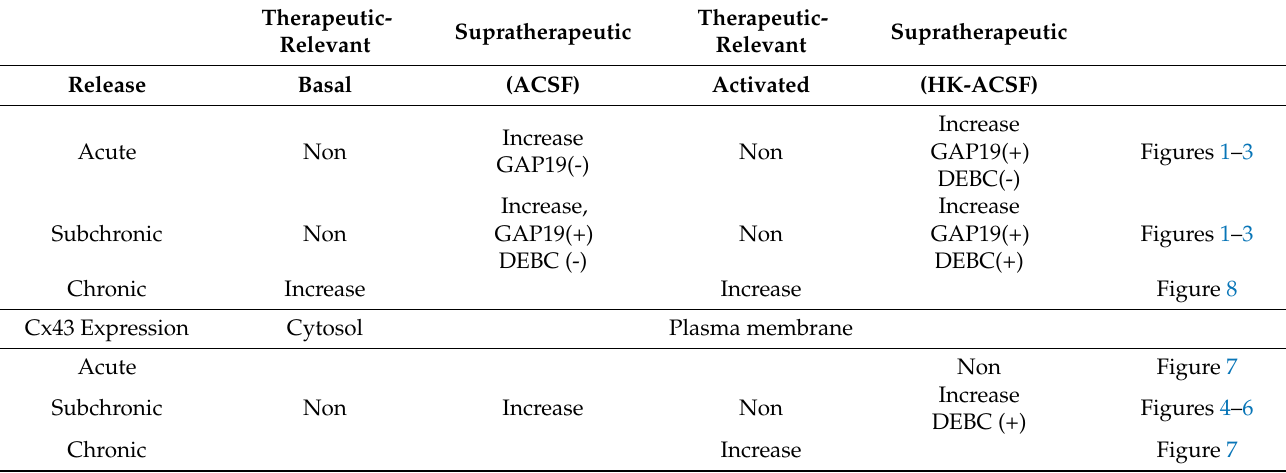
Table 1. Summary of the effects of zotepine (ZTP) on astroglial L-glutamate release and Cx43 expression in the